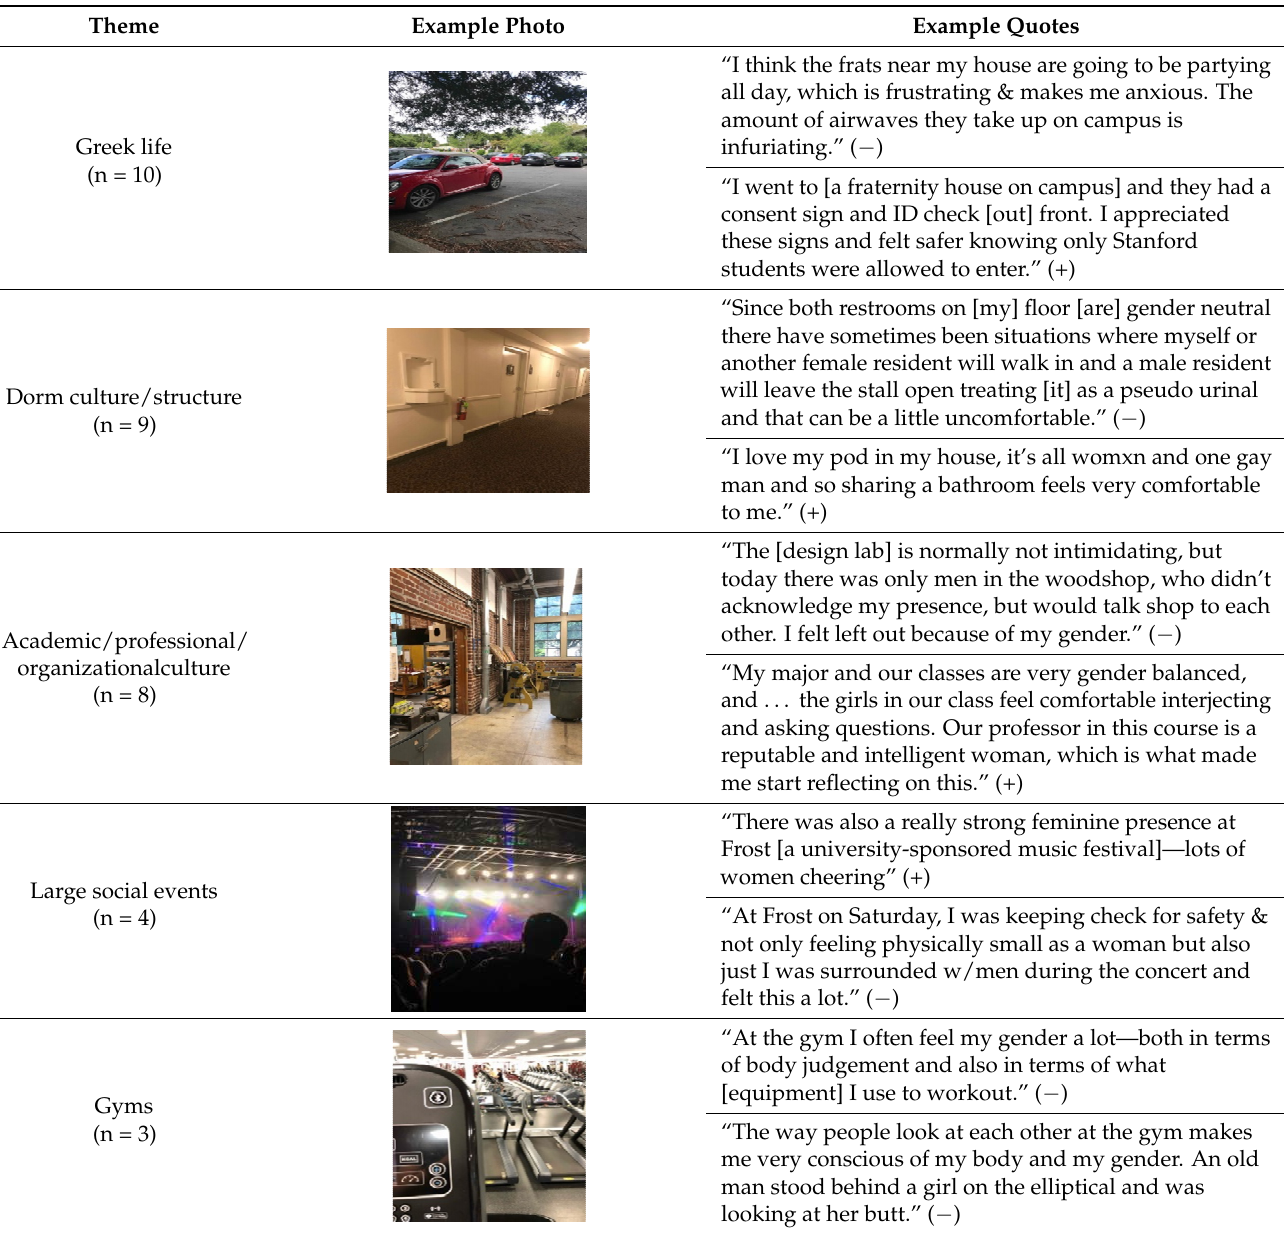
Table 1. Examples of data collected in pilot study by theme.